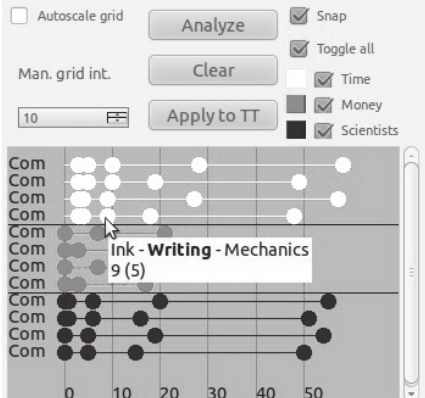
Figure 5: Possible technology paths to Computers in the tech tree of Figure 4 plotted for three resource types. The paths are depicted as horizontal successions (from left to right) of circles, each representing a technology. A partial screen capture from